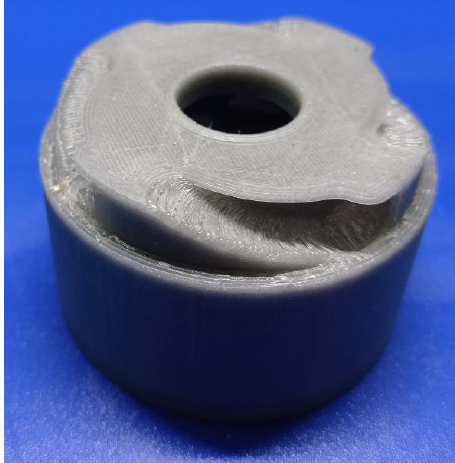
Figure 14. 3D model of the hybrid turbopump (variant). Source: authors’ development.